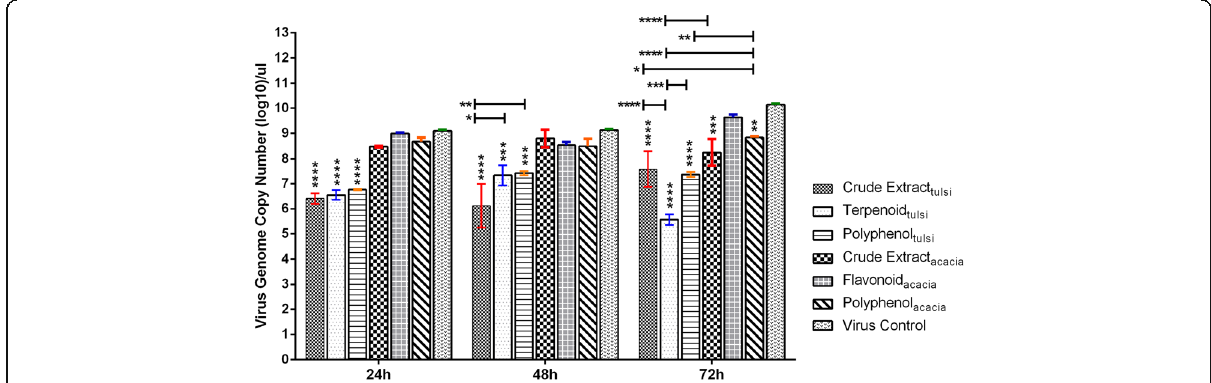
Fig. 4 Assessment of therapeutic activity of the O. sanctum and A. arabica leaves extracts in a time-dependent manner by Real Time RT-qPCR assay. Each error bar represents standard deviation (SD) from the 6 ECEs. The virus control group included 500 EID 50 /0.1 ml of H9N2 virus. Statistical significance was assessed by two ways analysis of variance (ANOVA) with Tukey post-hoc test (* p <0.05, ** p <0.01, *** p <0.001, **** p